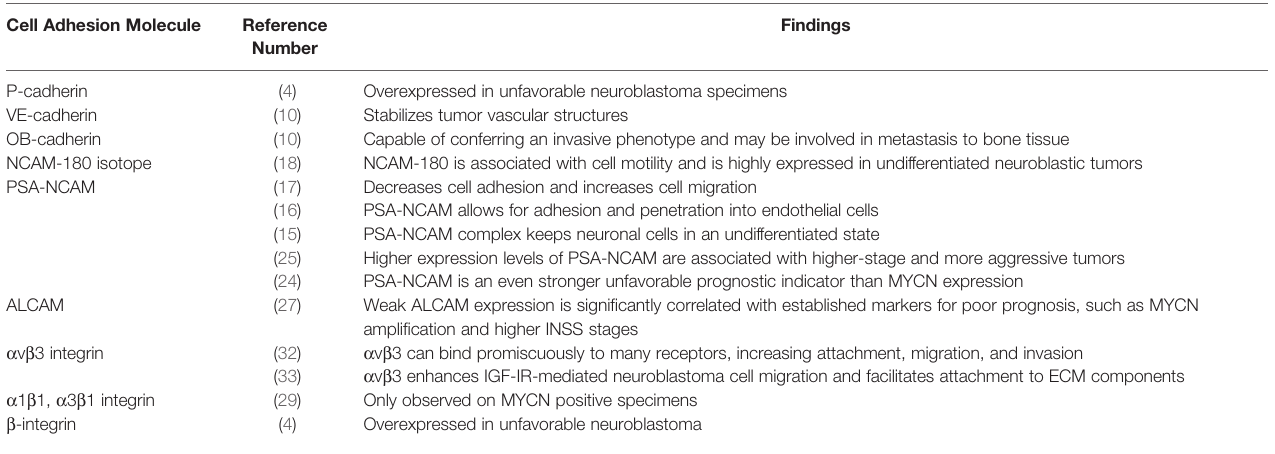
TABLE 2 | CAMs expressed in unfavorable neuroblastoma. Cell Adhesion